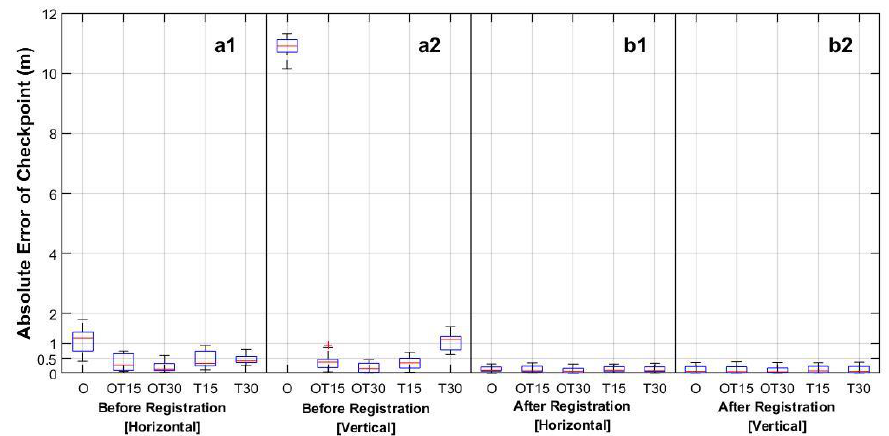
Figure 6. Boxplots describe the checkpoint absolute errors of the five schemes before and after point cloud registration in vertical and horizontal directions. Before point clouds registration ( a1 : horizontal direction; a2 : vertical direction); after point clouds registration ( b1 : horizontal direction; b2 : vertical direction).